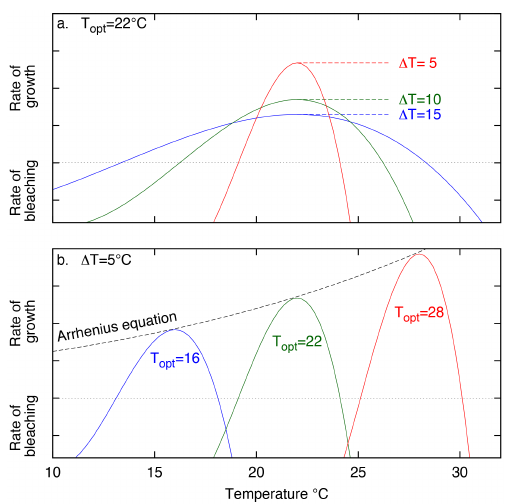
Figure 5. Illustration of the temperature dependence of biological processes in the model. Panel (a) shows the effect of changing the temperature range (cid:49)T while holding T opt fixed. Panel (b) shows the effect of changing T opt whilst holding (cid:49)T